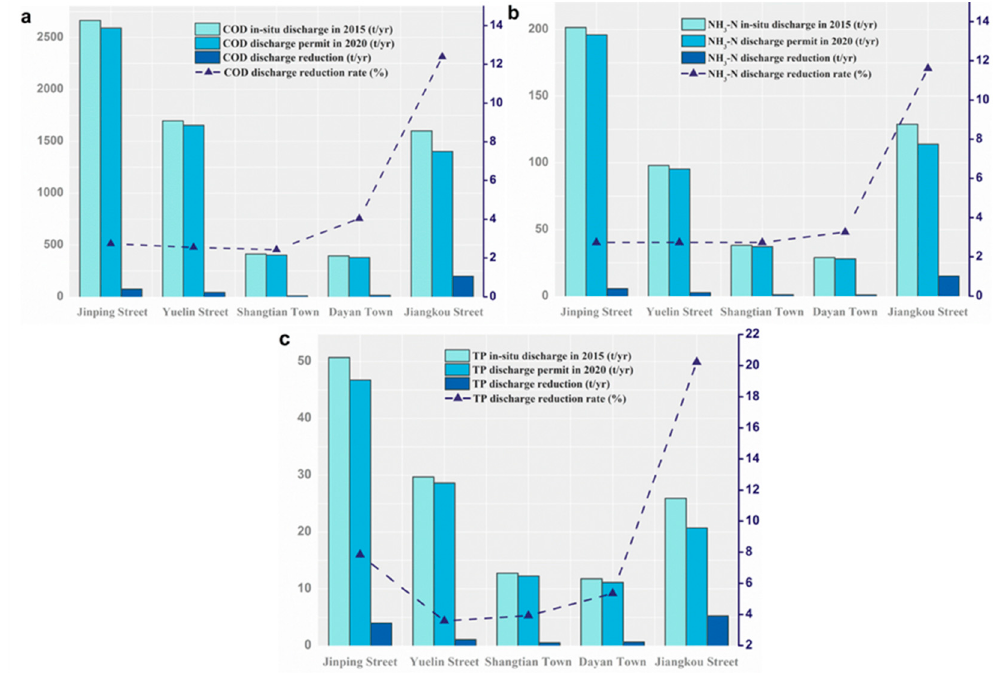
Figure 5. The in situ discharge (2015) and allocation of pollutant discharge quotas after optimization in the Xian-jiang watershed: ( a ) chemical oxygen demand (COD); ( b ) ammonia nitrogen (NH 3 -N); and ( c ) total phosphorus (TP).